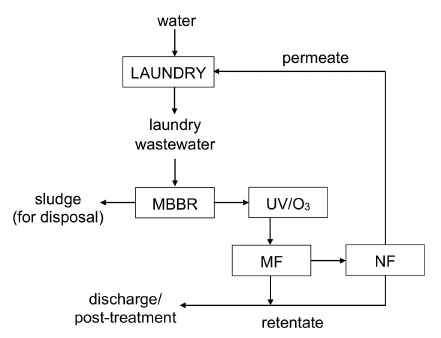
Figure 9. Schematic diagram of the proposed water cycle in laundry utilizing treatment and reuse of the laundry